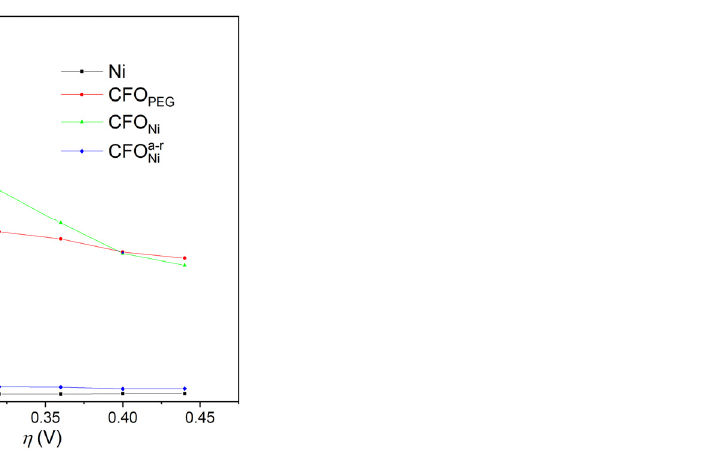
Figure 8. Double layer capacitance C dl versus overpotential η obtained for CoFe 2 O 4 electrodes in 1 M KOH during the oxygen evolution process.